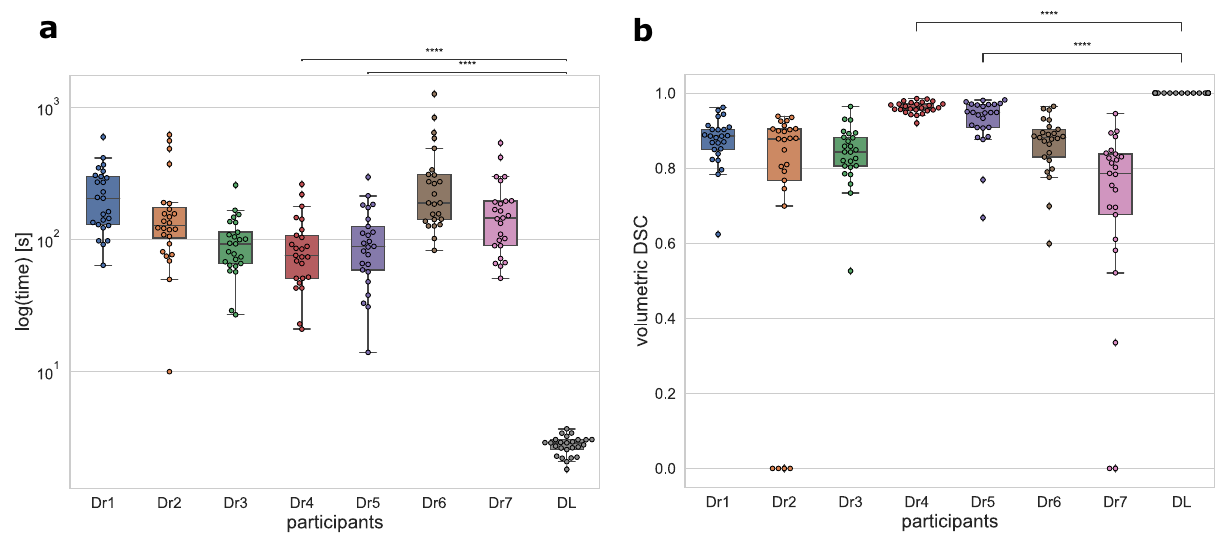
Fig. 5 Contouring time and intra-observer variability. Data were presented as box plots with overlaid swarm plots, where boxes are representing the interquartile range (IQR), extending from Q1 to Q3 and centered on the median value. Upper whiskers represent the highest data point that is less than Q3 + 1.5 × IQR. Lower whiskers represent the smallest data point that is greater than Q1 − 1.5 × IQR. Data points outside whiskers are considered outliers. P values were calculated using a two-sided Mann – Whitney – Wilcoxon test with Bonferroni correction and referred as follows: ****refers to the p value in the range: p ≤ 1.00e-04. The exact p values are reported in the order from the top to the bottom as they are displayed on the fi gures. Dr1, Dr2, Dr3, Dr4, Dr5, Dr6, and Dr7 — represent contours made by the medical doctors, DL — represents automatically generated contours. a Distribution of contouring time was obtained on the 25 NSCLC patients by seven participants and the automated method, corresponding p values are 2.816e-09 and 2.824e-09. b Volumetric dice similarity coef fi cient (DSC) representing intra-observer variability, across participants and the automated method, obtained on the 25 NSCLC patients, corresponding p values are: 1.946e-10 and 1.946e-10.